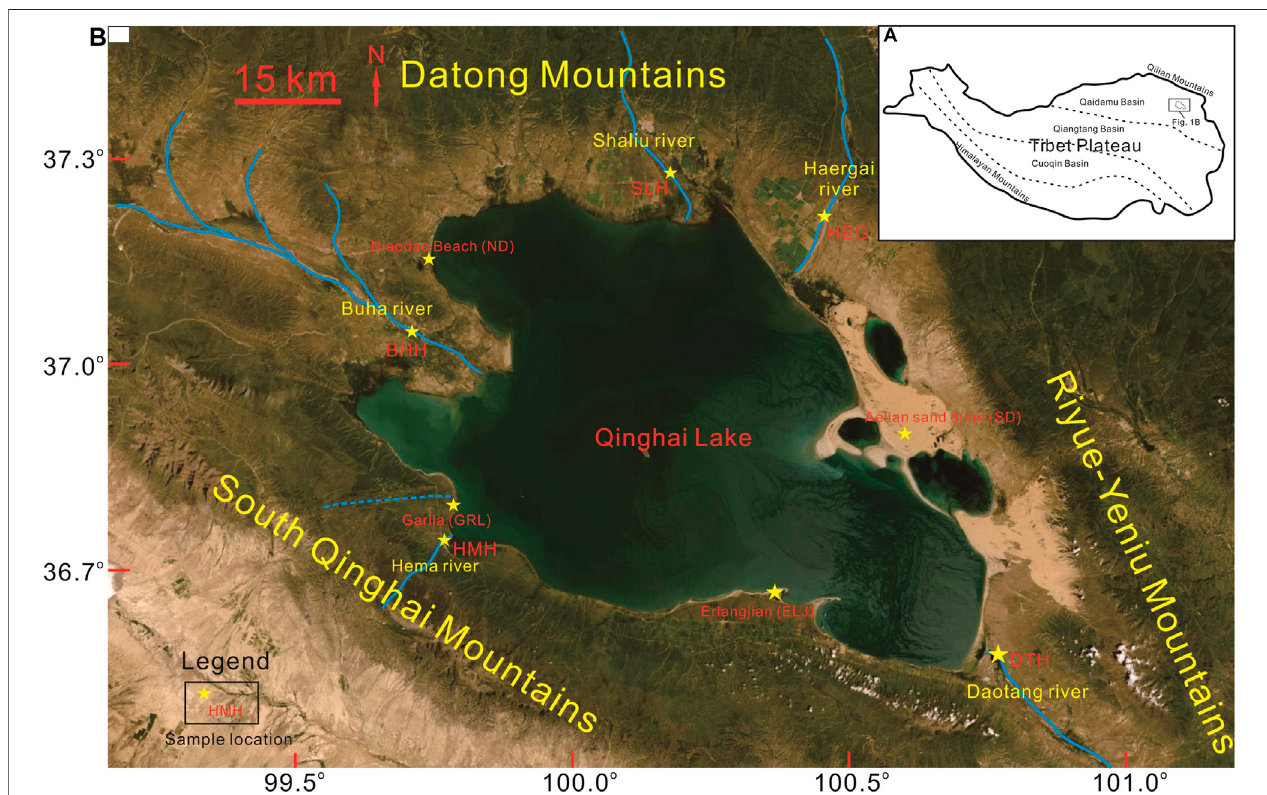
FIGURE 1 | Location of the study area and sampling sites (image modi fi ed from Google Earth). (A) Schematic map of the Tibet Plateau and the location of Qinghai Lake. (B) : The surrounding mountains, main rivers, and sampling sites of Qinghai Lake.